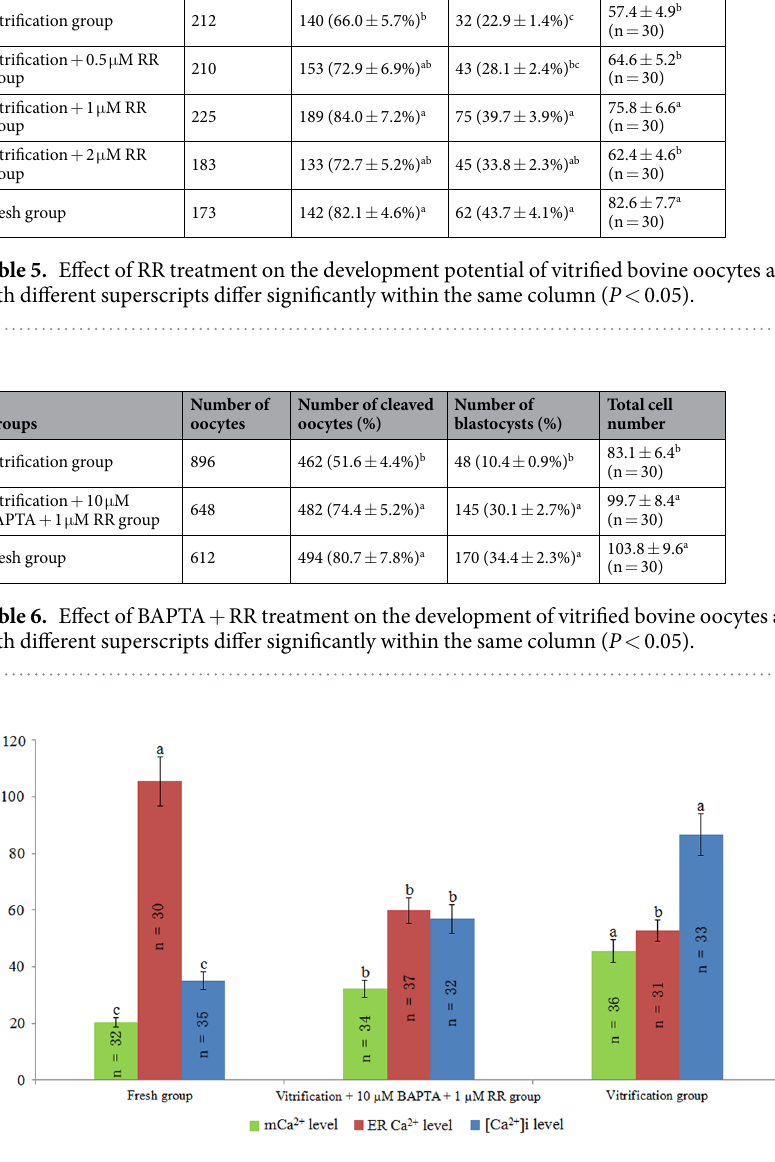
Figure 4. Effect of BAPTA + RR on Ca 2 + levels in vitrified bovine oocytes. a,b,c Values with different superscripts differ significantly between groups ( P < 0.05).